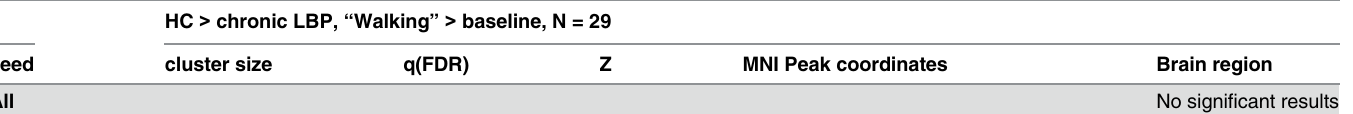
Table 6. Functional connectivity cluster maxima of the healthy controls (HC) vs. chronic Low Back Pain (LBP) group, contrast walking activities ( “ Walking ” ). All results are false discovery rate corrected (FDR, q < 0.05). MNI = Montreal Neurological